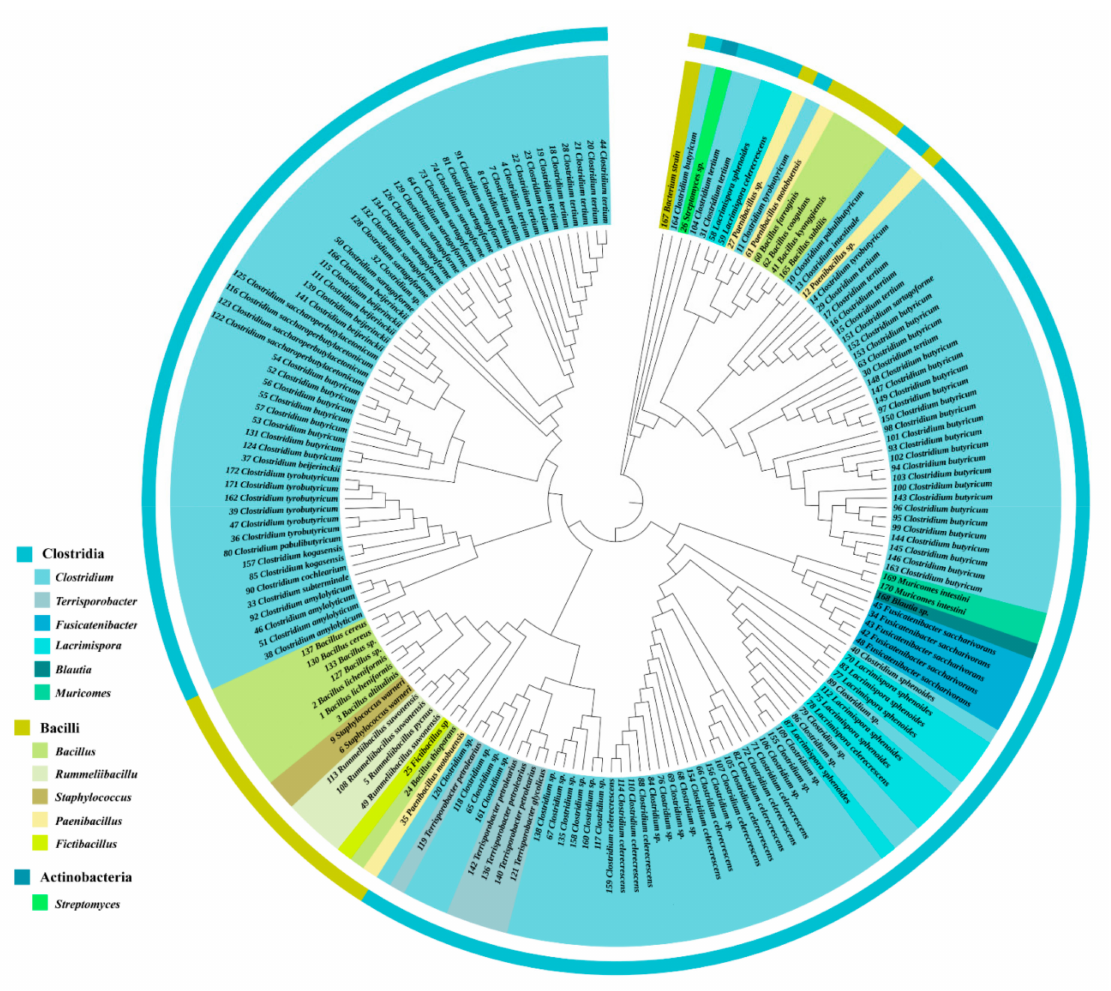
Figure 1. Phylogenetic tree of pit mud isolates constructed by the Neighbor-joining method using the 16S rRNA gene